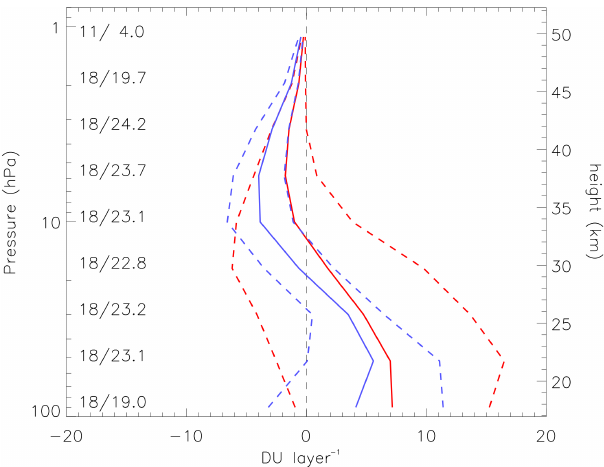
Fig. 15. The mean of the differences between GOME-2 and the lidar at Río Gallegos (DUlayer − 1 ) for the retrieval (blue) and the a priori (red). The solid line is the mean, and the dashed lines are the ± 1 standard deviations. The first number in the column on the left side is the number of collocations between GOME-2 and the lidar and the second number is the mean number of lidar layers averaged for that layer during